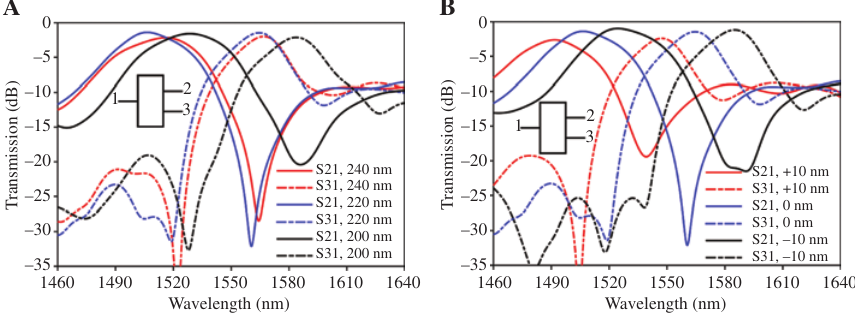
Figure 4: Simulated and measured S-parameters for the focused wavelength demultiplexer, where S (A) Simulated S-parameters by using Lumerical FDTD Solutions. (B) Measured S-parameters of the fabricated demultiplexer, there is oscillations in the long-wavelength range because it exceeds the effective wavelength range of the grating couplers.